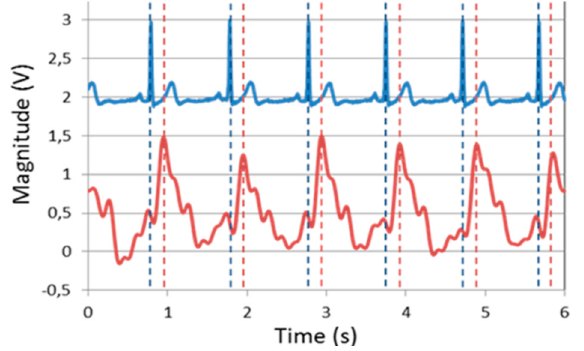
Figure 6. Comparison between classical ECG (blue) with our sensor (red) measuring the pulse wave.